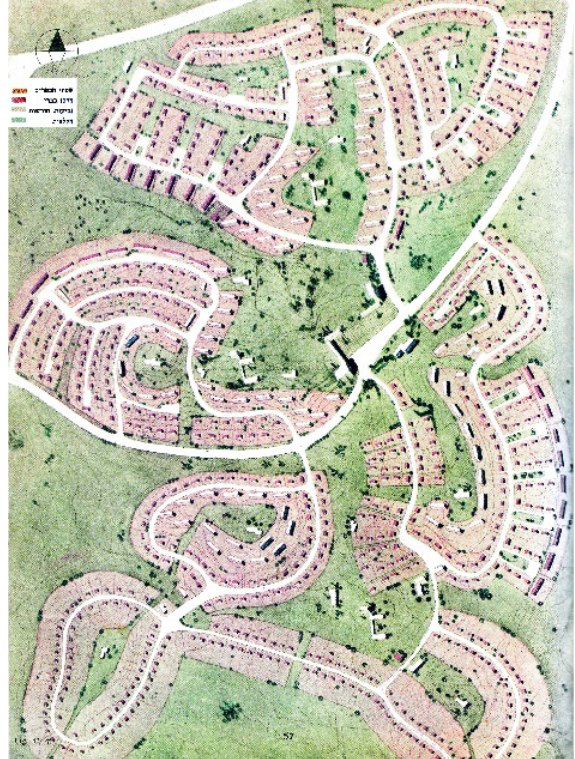
Figure 1. The new town of Kiryat Shmona: Disconnected neighborhoods. On the right and in yellow, auxiliary farm neighborhoods. Notes: From top to bottom, it is written “residential areas,” “auxiliary farms,” “commer‐ cial center,” “industrial zone,” “regional services,” “green spaces,” and “agriculture.” Source: Sharon (1951, p. 37).